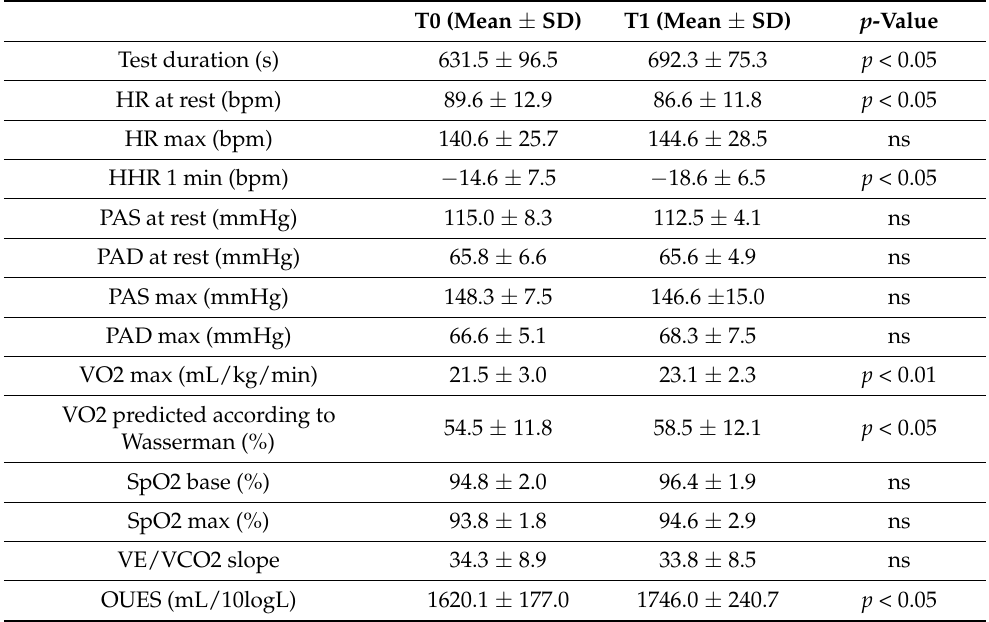
Table 1. Comparison of cardiopulmonary test parameters between T0 and T1. ns = not significant.